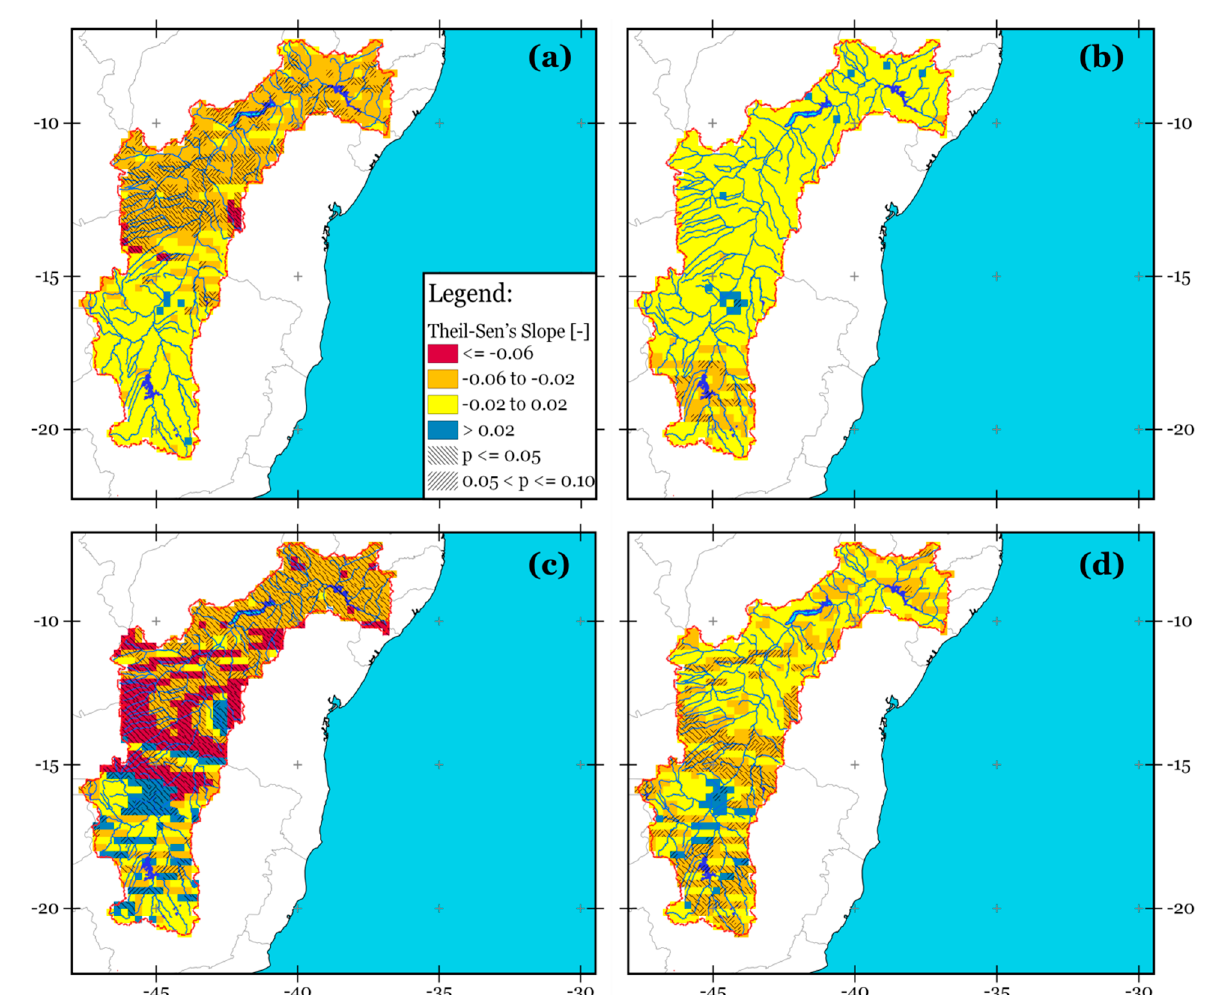
Figure 4. Same as Figure 3, but for SPEI3 at: ( a ) February (DJF), ( b ) May (MAM), ( c ) August (JJA), and ( d ) November (SON).